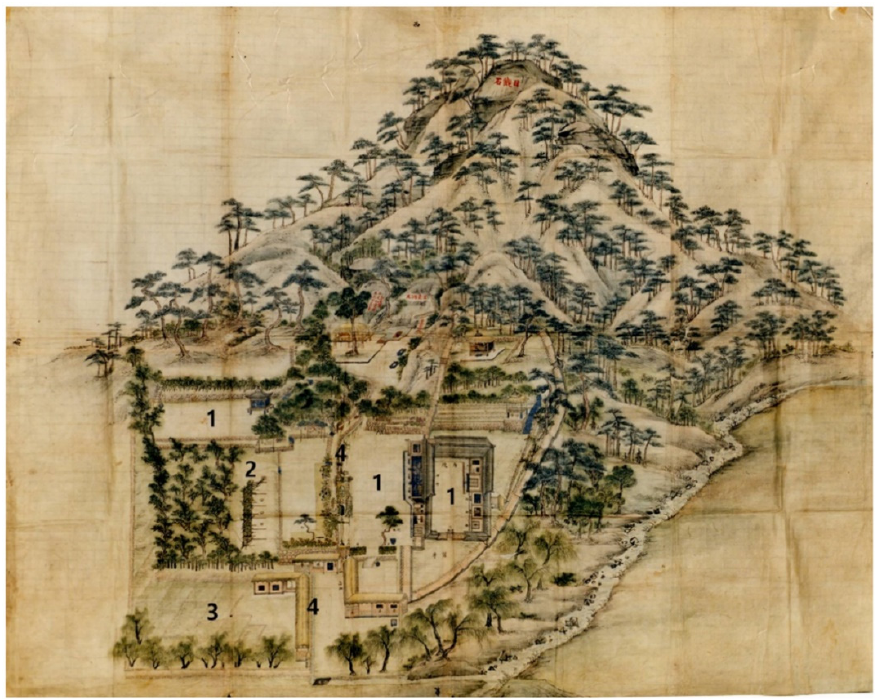
Figure 3. Sustainable elements of the outer space of a private house shown in Okhojeongdo painting, 1815. Ink and colors on paper, 193 cm × 150 cm. National Museum of Korea, Seoul. (1) yard (multifunctional vacant land), (2) orchard, (3) vegetable garden, (4) waterway, pond.